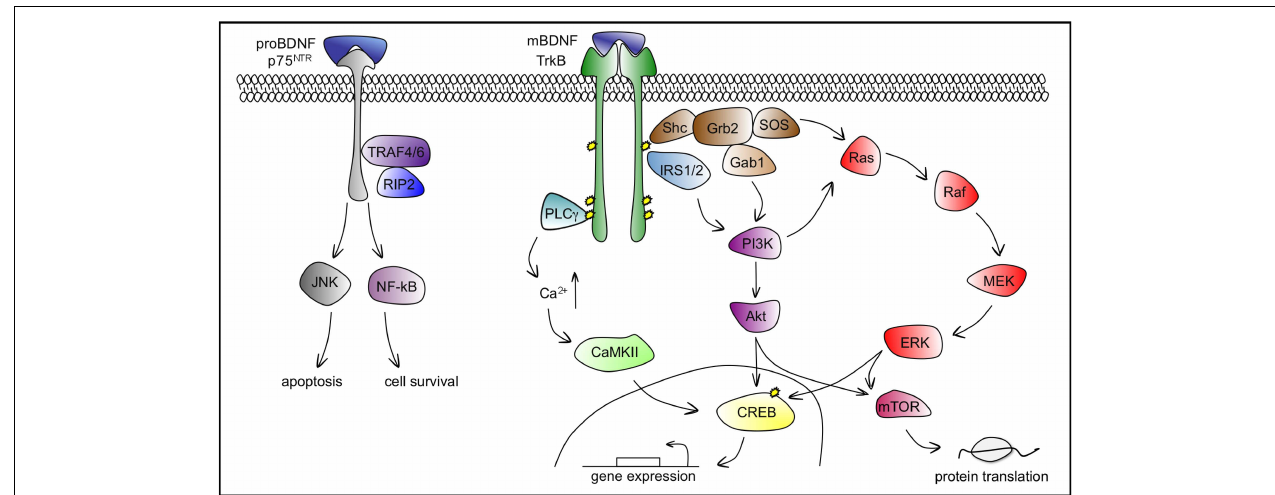
FIGURE 3 | BDNF–TrkB and BDNF–p75 NTR signalling pathways. BDNF binds TrkB with high affi nity to induce its dimerization and autophosphorylation of tyrosine residues in the cytoplasmic kinase domain that serve as docking sites for effector molecules and trigger the activation of three main signalling pathways: PLC γ , PI3K and ERK cascades, which ultimately lead to the phosphorylation and activation of the transcription factor CREB that mediates transcription of genes essential for the survival and differentiation of neurons. The recruitment of PLC γ increases intracellular Ca 2 + levels and leads to the activation of CaMKII to phosphorylate CREB. PI3K can be activated via the Shc/Grb2/SOS complex through Gab1 and by IRS1/2. Lipid products generated by the activated PI3K, the phosphatidylinositides, bind and activate protein kinase Akt, upstream of CREB. The ERK cascade can be activated both by the Shc/Grb2/SOS complex and by